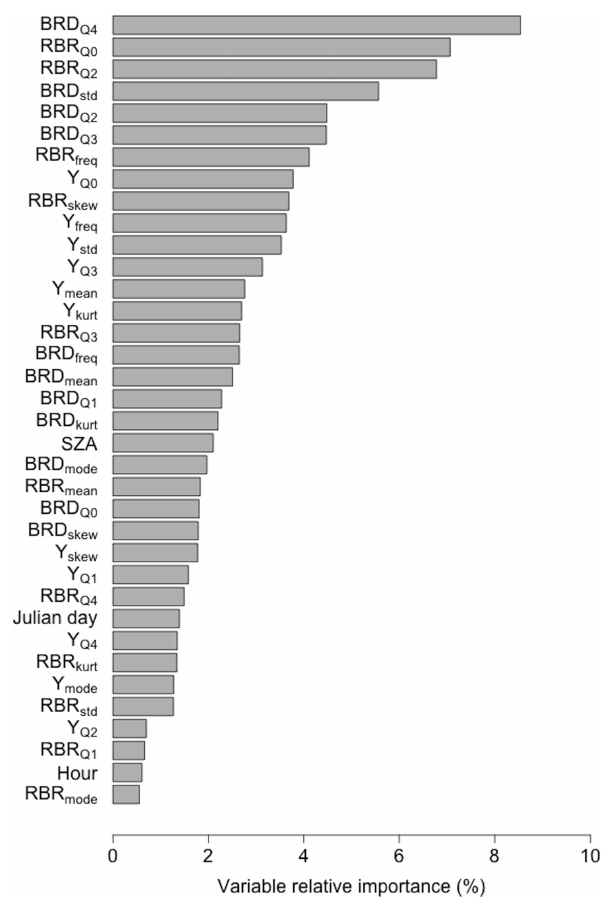
Figure 5. Variable relative importance of the SVR model on training